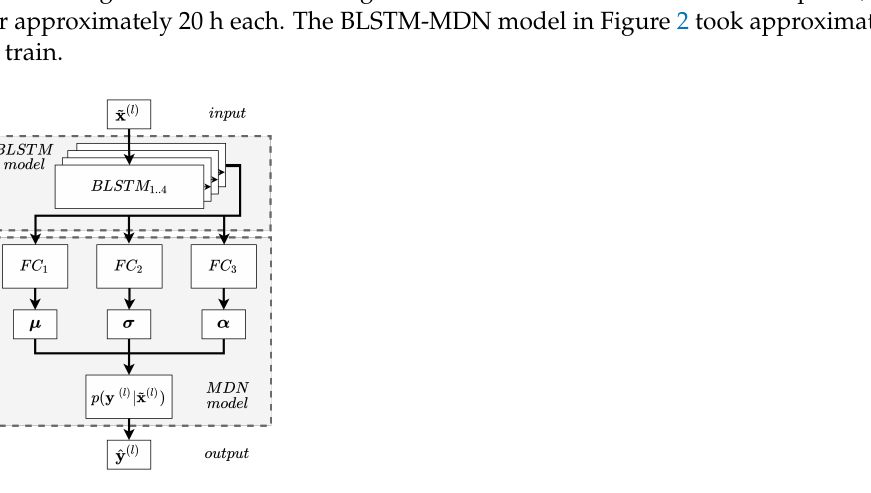
Figure A1. Deep learning model used to estimate the number of mixtures.